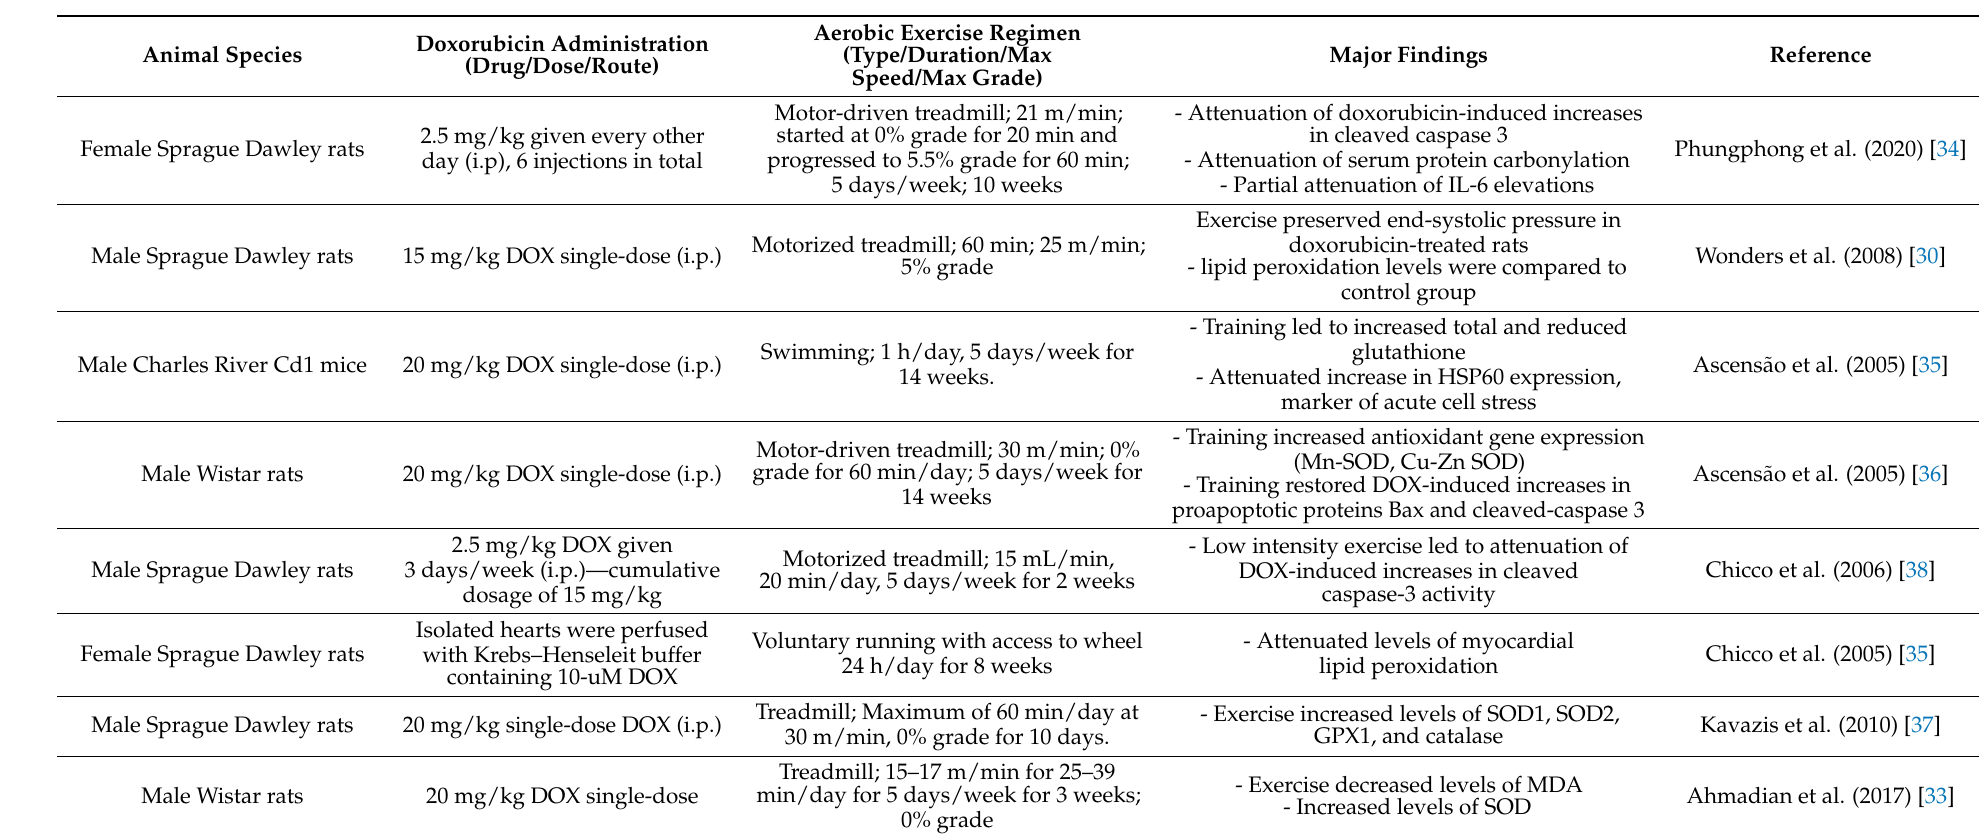
Table 1. Pre-clinical Aerobic Exercise